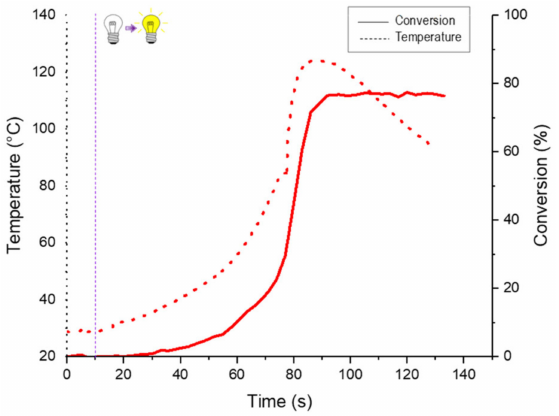
Figure 8. Simultaneous RT-FTIR (C = C conversion vs. irradiation time) and thermal imaging (temperature vs. irradiation time) photopolymerization follow-ups (1.4 mm sample) under air upon LED@405 nm irradiation for Mix-MA in the presence of Napht (0.1 wt.%), Ar 2 I + PF 6 − (1.5 wt.%), 4-dppba (0.5 wt.%), and Blocbuilder ® MA (2 wt.%); irradiation starts after 10